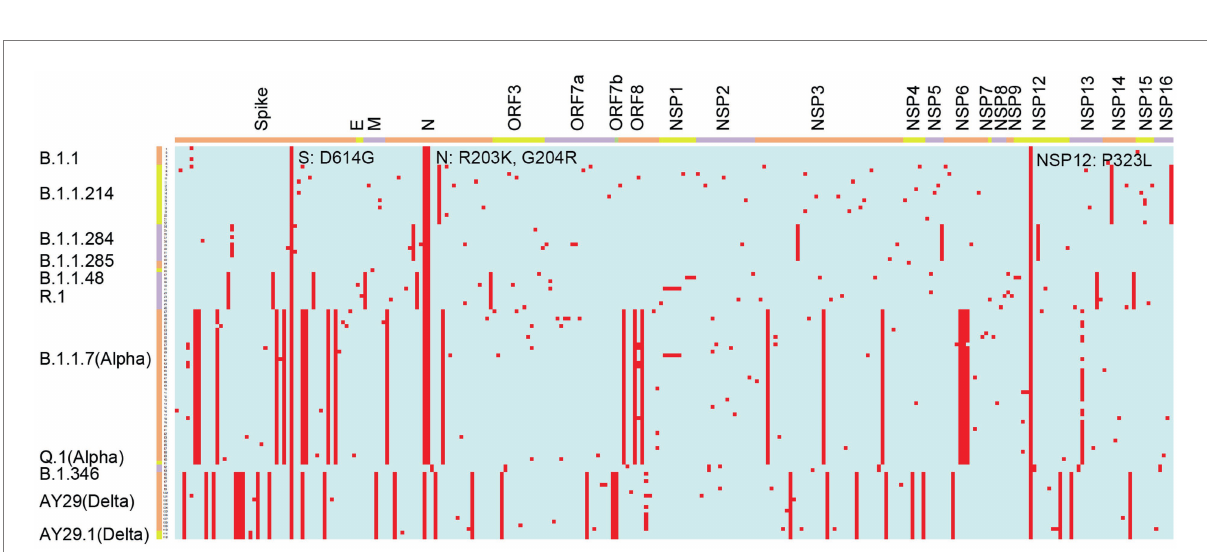
FIGURE 3 Graphical representation of amino acid changes in the SARS-CoV-2 genomes identified at Juntendo University Hospital. Amino acid substitutions are colored in red. The viral genes are shown on the top and the lineages are indicated on the